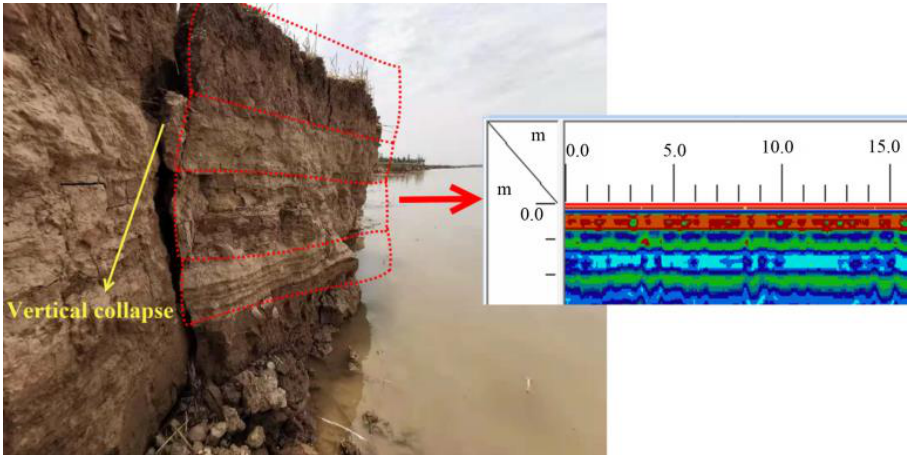
Figure 4. The s can result of a section in Wantan Town. Figure 4. The scan result of a section in Wantan Town. Table 2. Part test results of the brown soil.